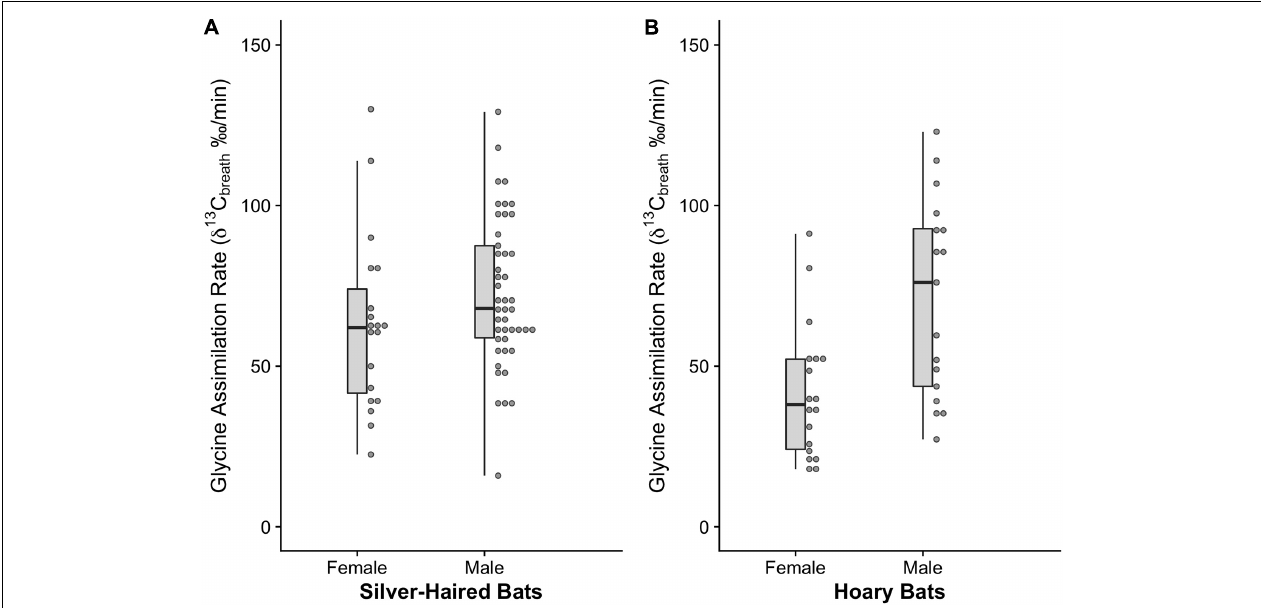
FIGURE 4 | 13 C enrichment 10 min post-ingestion of 13 C-labeled glycine (indicator of assimilation rate) in spring migrating silver-haired ( Lasionycteris noctivagans ) and hoary bats ( Lasiurus cinereus ). (A) Enrichment did not differ between female and male silver-haired bats, but (B) female hoary bats had depleted 13 C relative to males, suggesting reduced digestive